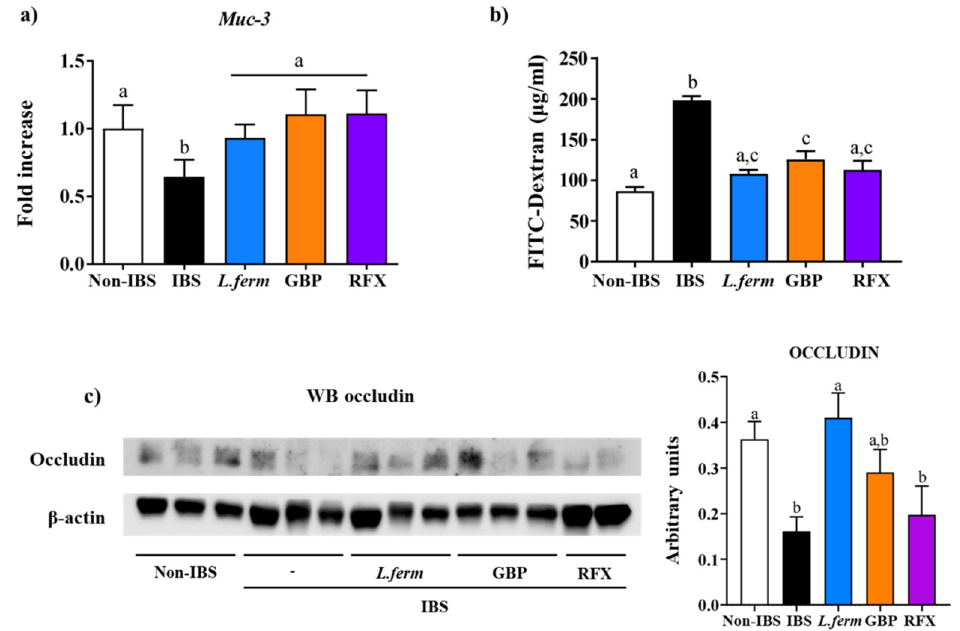
Figure 8. Intestinal permeability evaluation two weeks after DCA vehicle (Non-IBS), 4 mmol/L DCA (IBS), L. fermentum (10 9 CFU) ( L. ferm ), Gabapentin at 70 mg/kg (GBP) or Rifaximin at 150 mg/kg (RFX) administration. ( a ) Muc-3 gene expression; ( b ) FITC-dextran assay and ( c ) occludin protein expression. Groups with different letters statistically differ ( p < 0.05).